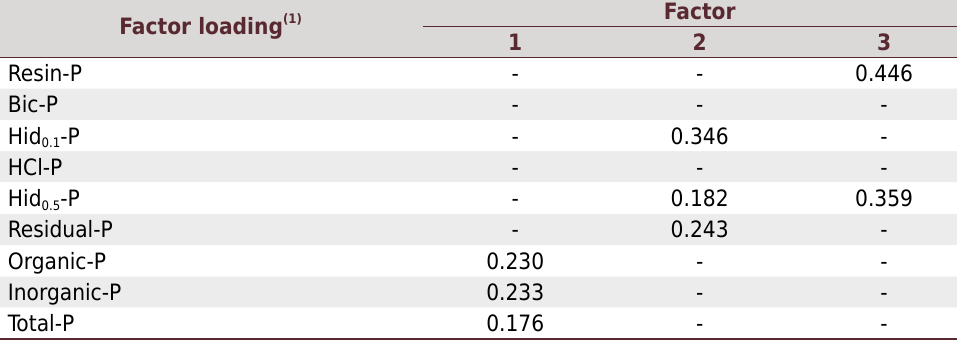
Table 4. Factor analysis of soil P in different fractions